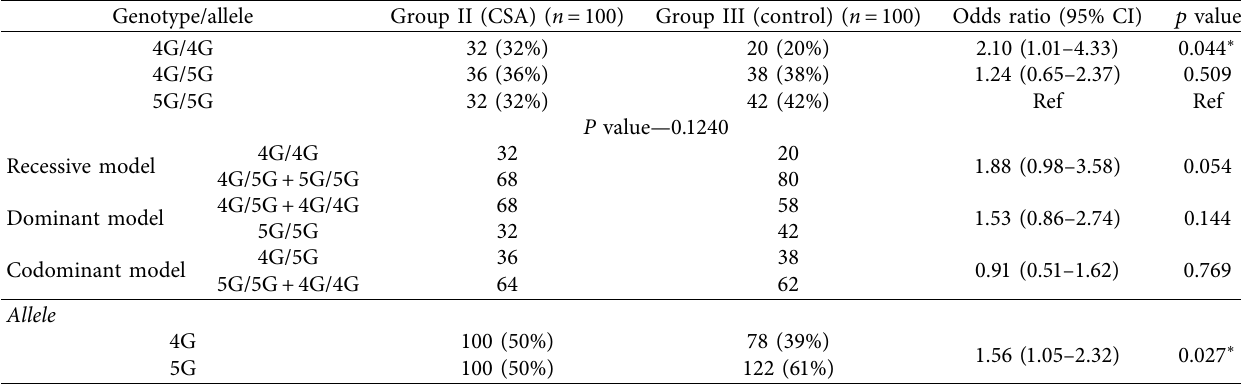
Table 4: Distribution of genotype and allelic frequency and association analysis of 4G/5G polymorphism with CSA under different genetic models.